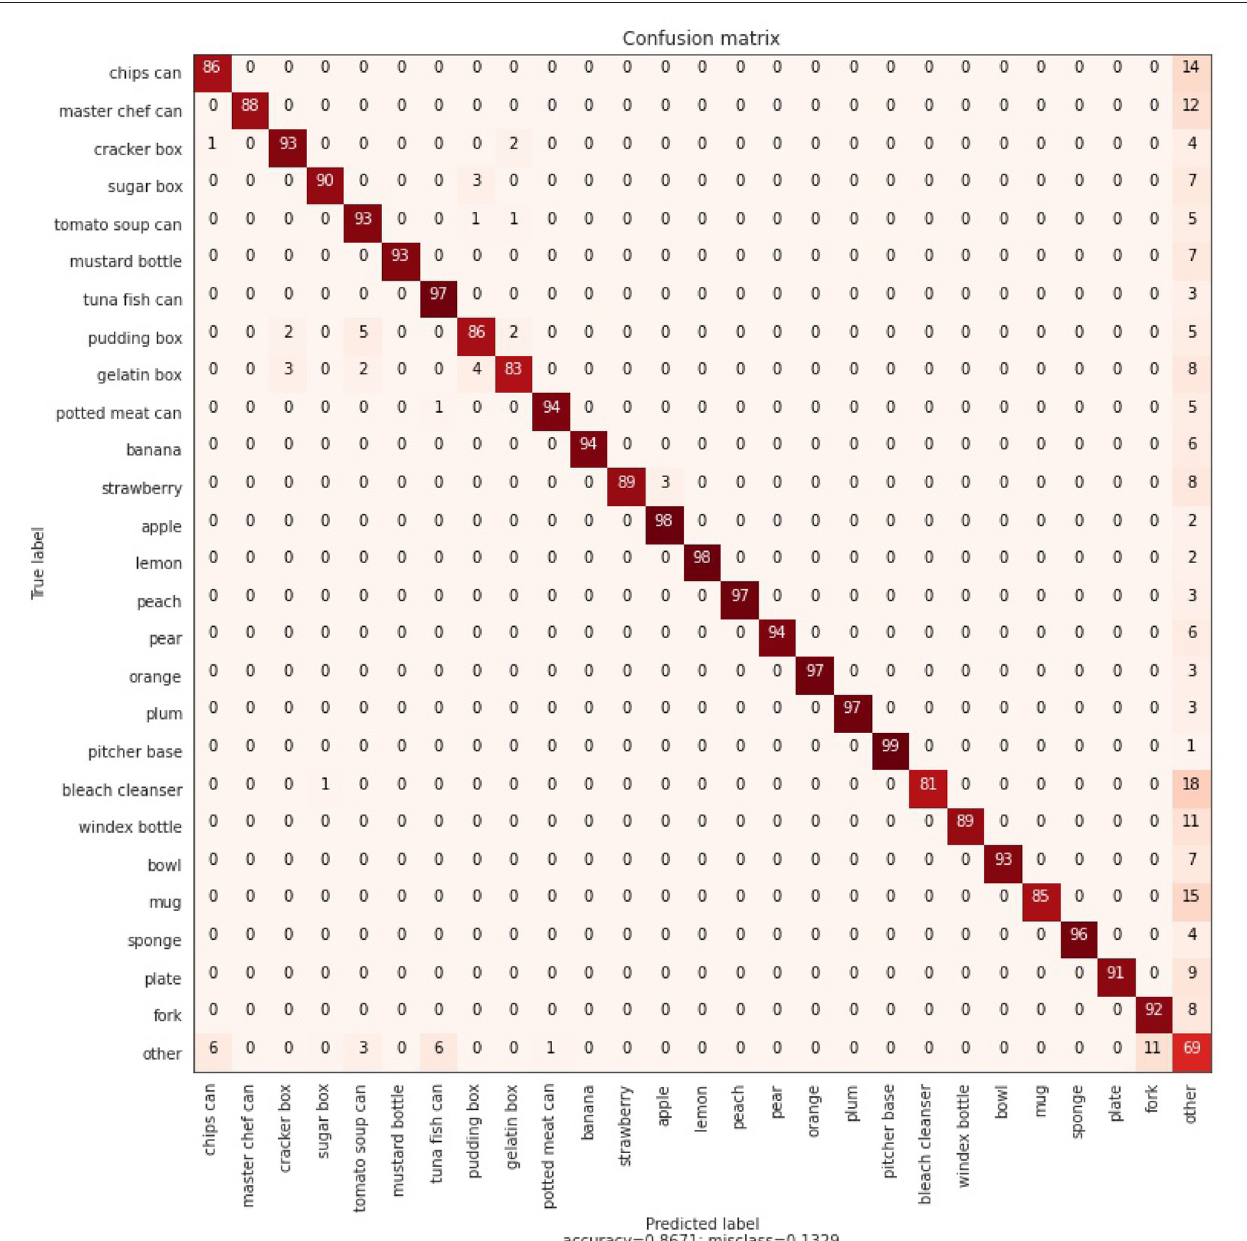
strawberry and the apple, a large red circle is reconstructed.